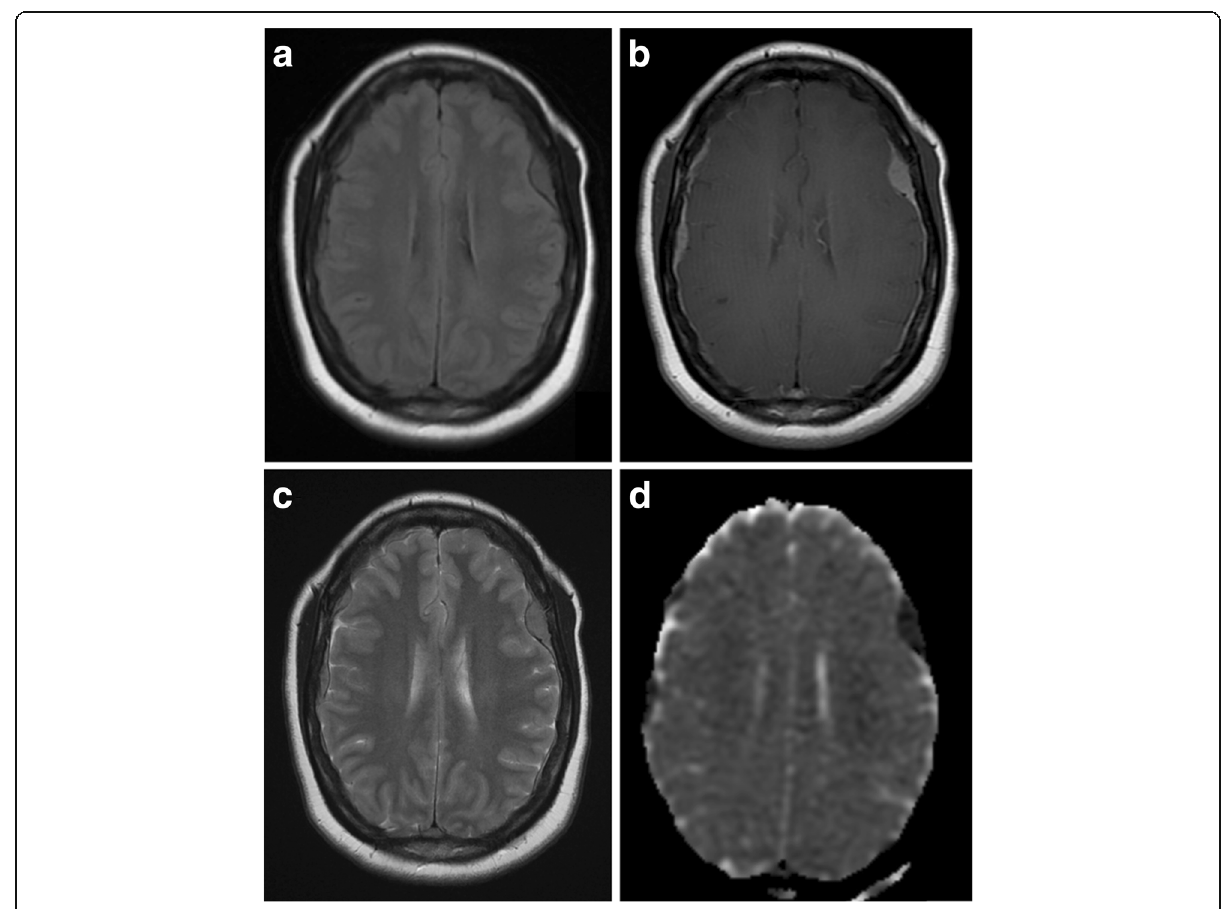
Fig. 9 Multifocal dural lymphoma. a , b Pre- and post-contrast axial T1-weighted MR images showing diffuse dural thickening and enhancement with superimposed dural masses. c Axial T2-weighted MR image of the same lesions. d Apparent diffusion coefficient (ADC) map showing intense restricted diffusion within the multiple dural mass lesions in keeping with high